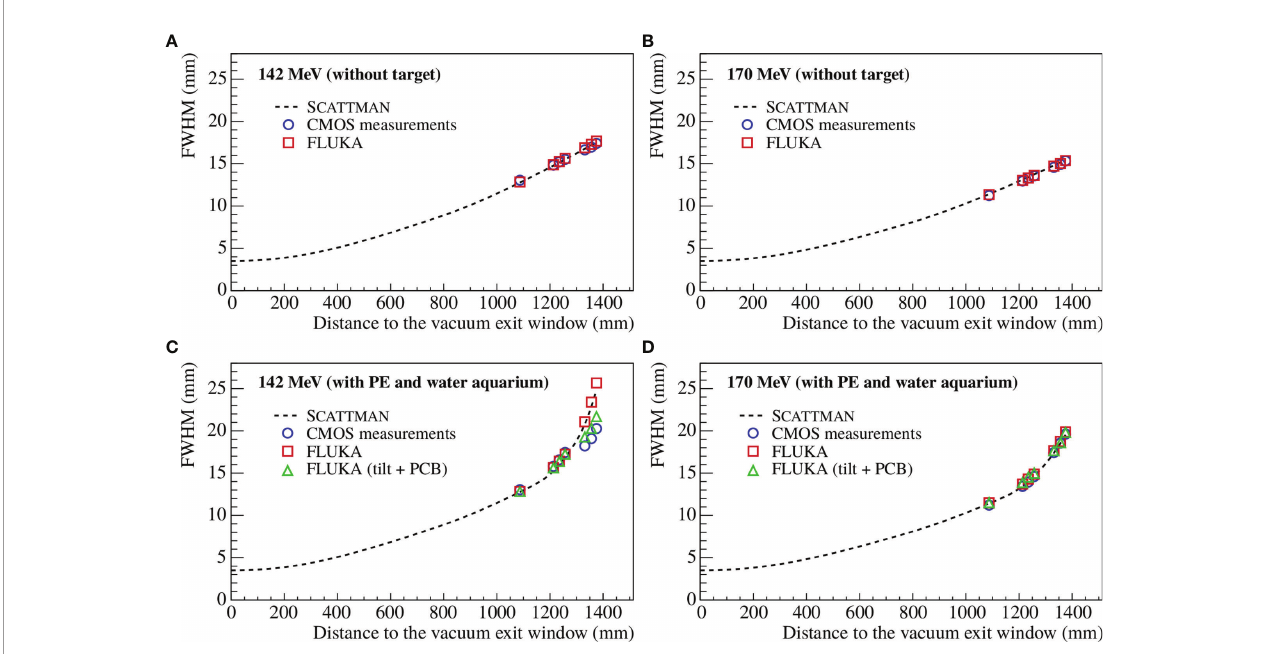
FIGURE 10 | Beam width as a function of the distance to the vacuum exit window for 142 MeV (A, C) and 170 MeV (B, D) with the initial beam optics from Table 7 . The beam width was computed for S CATTMAN , the CMOS measurements, and the FLUKA simulation without target (A, B) and with the PE block and the water aquarium (C, D) . The Monte Carlo simulations were performed with and without including the initial beam tilt and the PCB of the sensors.